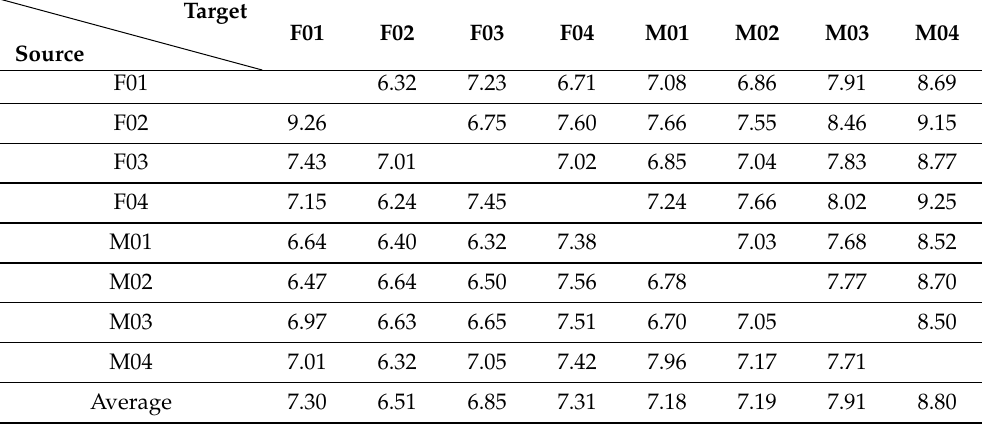
Table 4. MCD of voice conversion (dB) during the speaker adaptation on acoustics. The diagonal cells are empty, because voice conversion is not applicable to the same